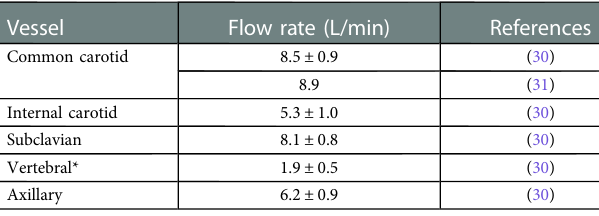
TABLE 1 Distribution of cerebral volumetric fl ow rates from the literature. The fl ow rate values are reported as mean±standard deviation (SD).